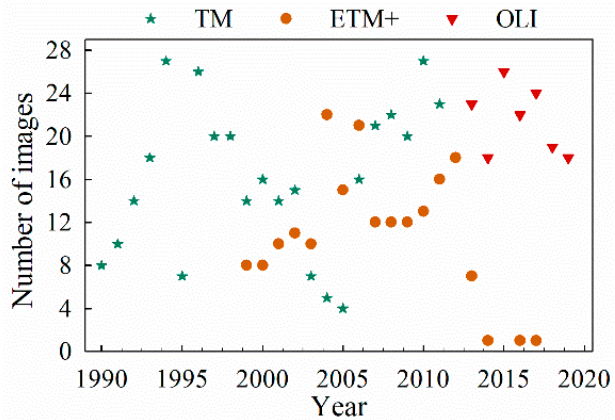
Figure 2. Time series of Landsat thematic mapper (TM), enhanced thematic mapper (ETM+), and operational land imager (OLI) remote sensing images in the Tien Shan Range show the number of images acquired for each year 1990–2019.